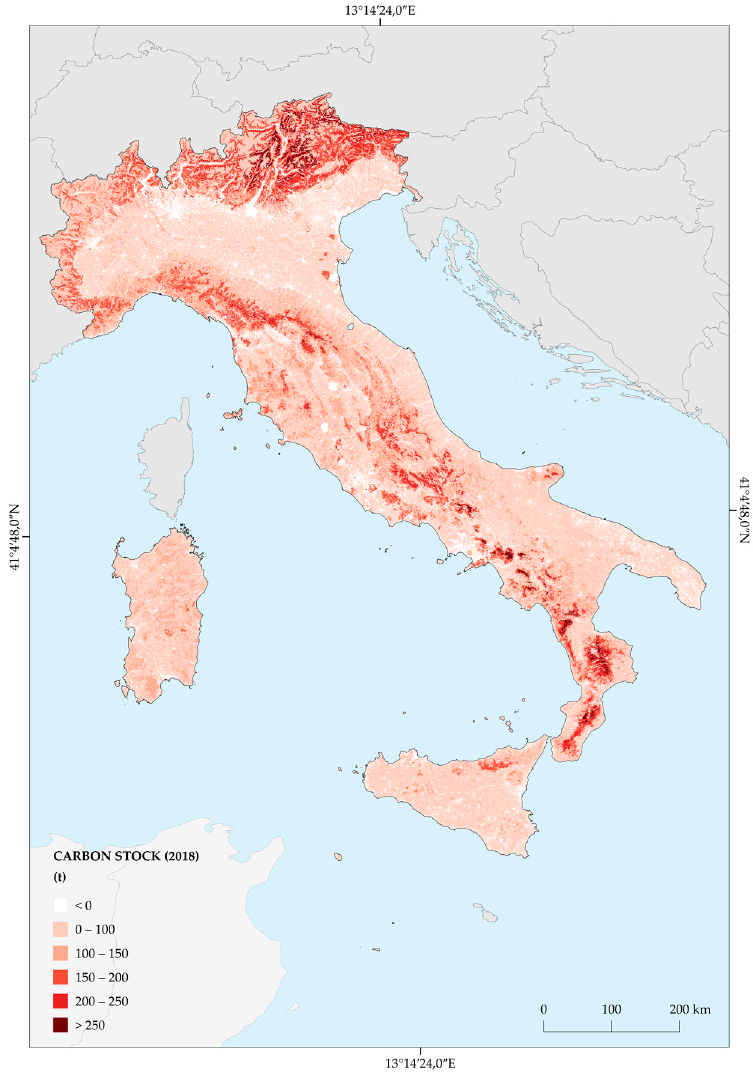
Figure 5. Carbon stock (2018).